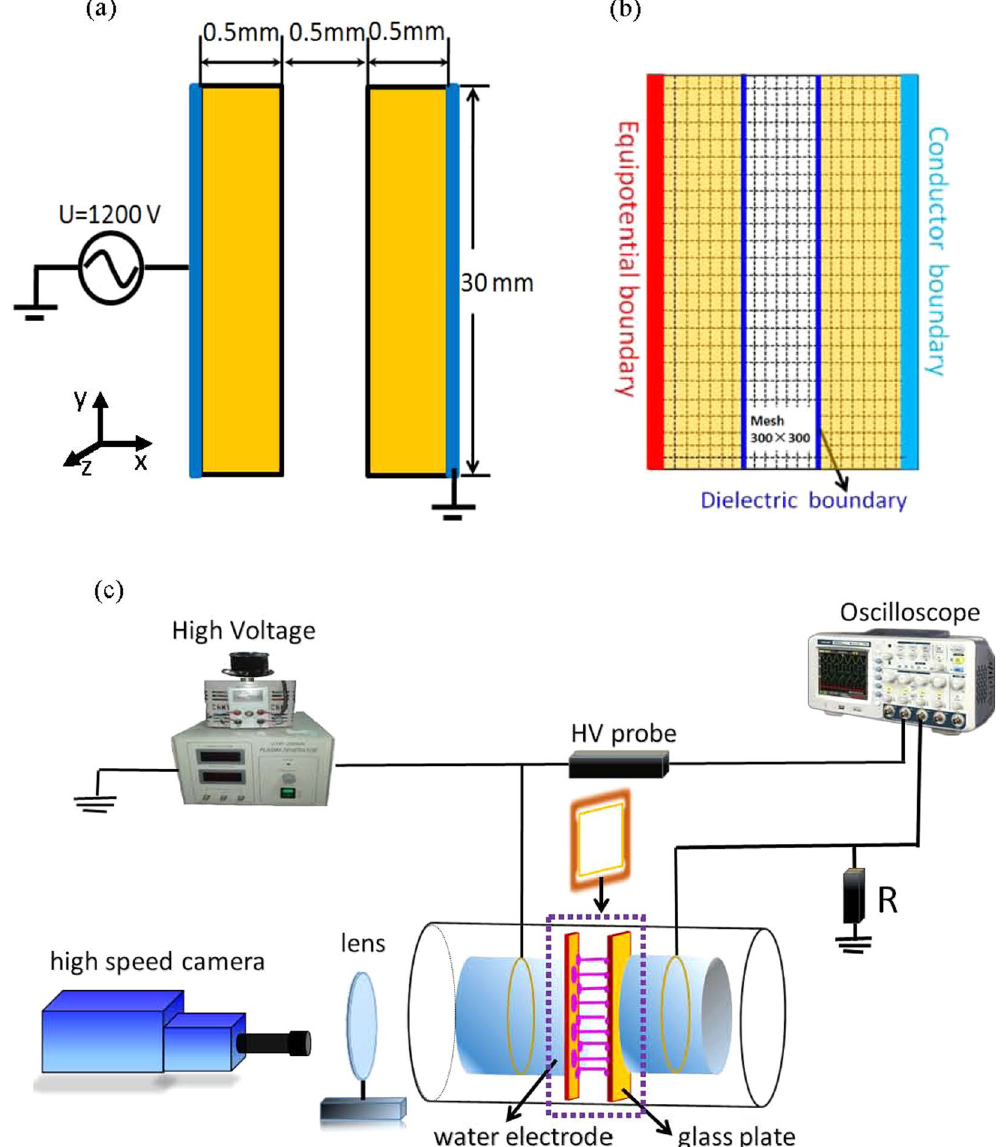
Figure 1. Schematic diagrams of the dielectric barrier discharge used in simulation ( a , b ) and in experiment ( c ). The configuration within the dashed regions in ( c ) is similar to our simulation